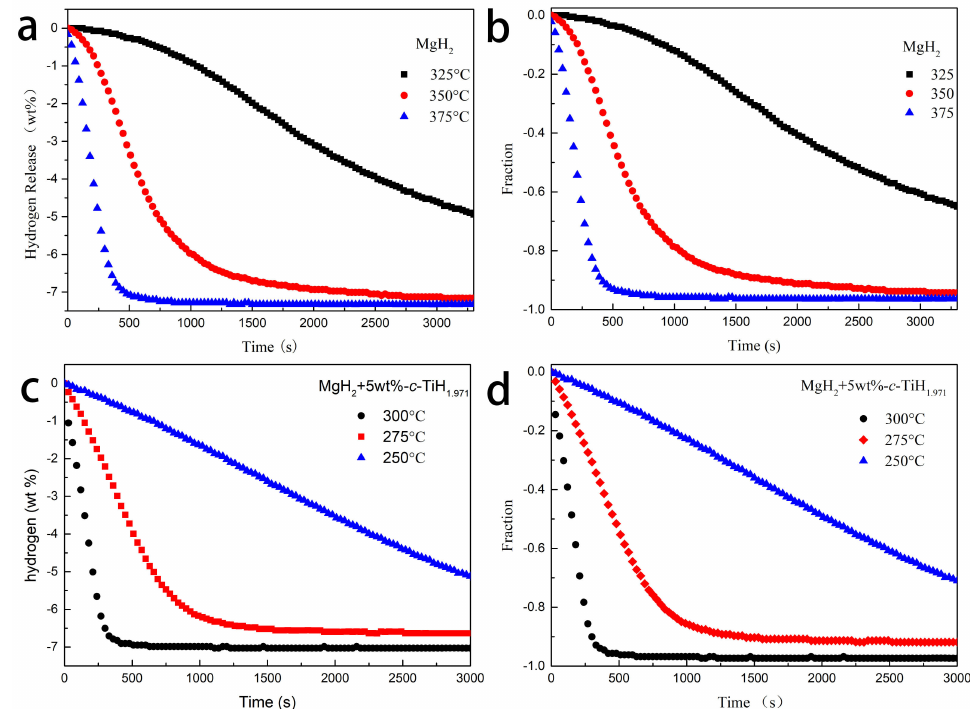
Figure3. Isothermaldehydrogenationcurves ( a )and normalizedisothermal dehydrogenation curves( b ) from prepared MgH 2 at di ff erent temperatures, isothermal dehydrogenation curves ( c ), and normalized